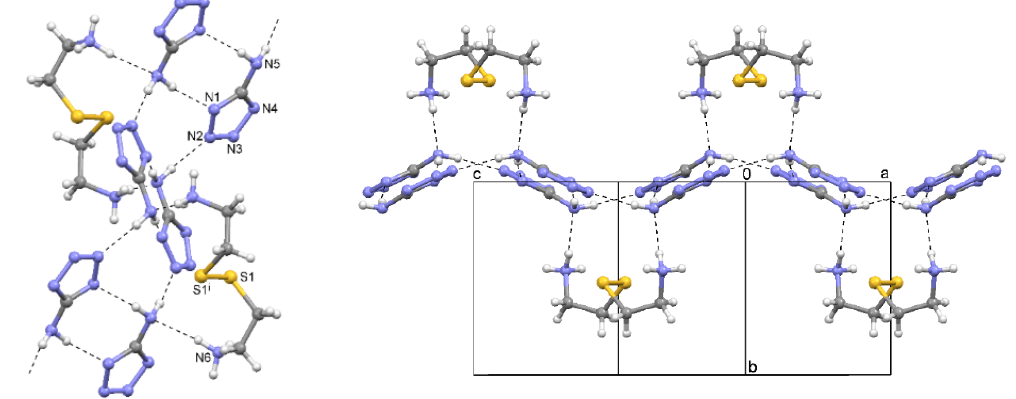
Figure 4. ( a ) Interactions in the crystal structure of 2 ; i: − x , y , 3/2 – z ; ( b ) Packing